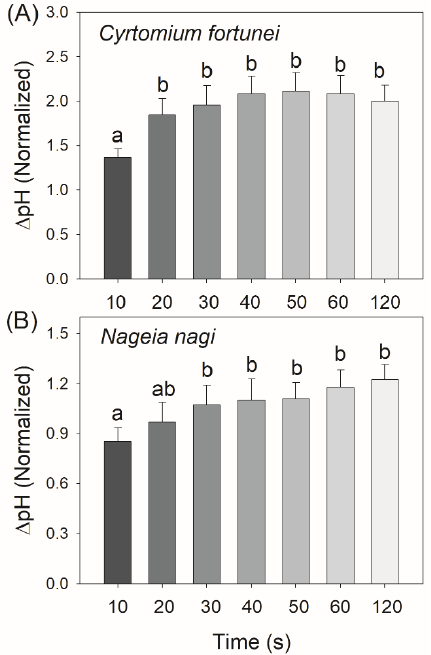
Figure 4. Changes in the trans-thylakoid proton gradient (∆pH) after transition from 59 to 1809 μmol photons m −2 s −1 in leaves of Cyrtomium fortune ( A ) and Nageia nagi ( B ). All the ΔpH levels were normalized against the magnitude of ECS ST . The data are the means ± SE (n = 5). Different letters indicate significant differences between the different treatments.